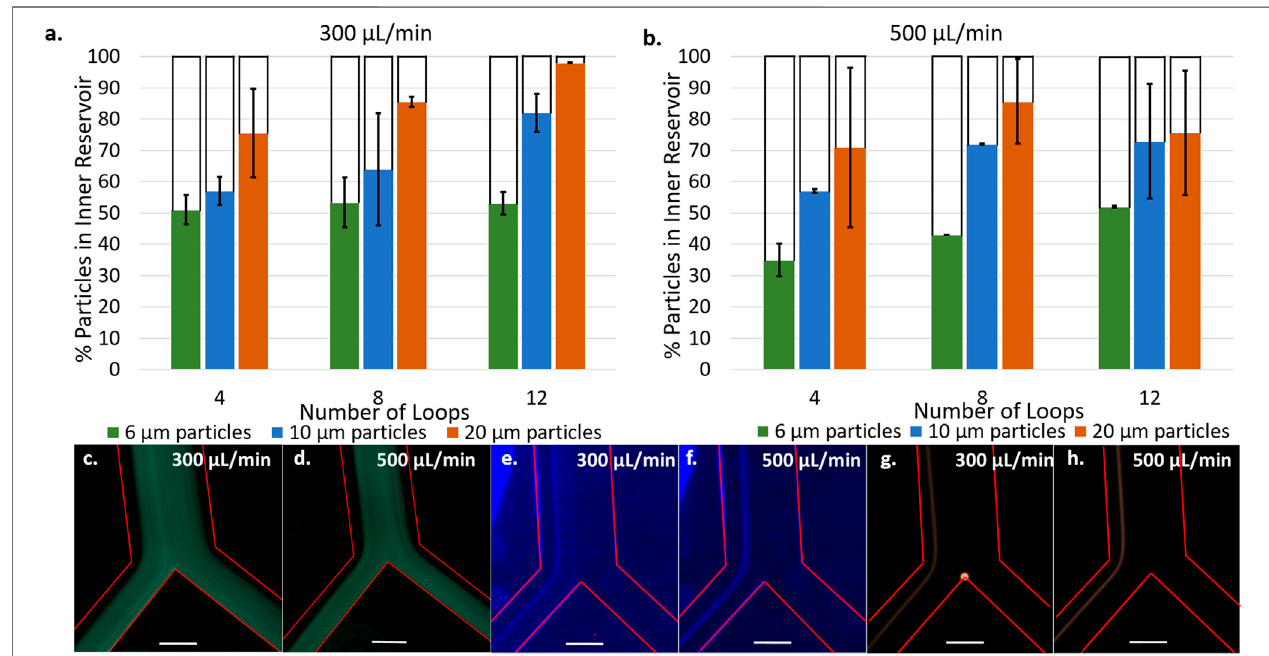
FIGURE4 | Percentage ofparticles counted in inner reservoir in devices with4, 8, and 12loop spirals with 6,10,and 20 µm particles at 300 μ l/min (A) and 500 μ l/ min (B) . [6 µm particles] (cid:2) 5.5 × 10 2 particles/mL, [10 µm particles] (cid:2) 1.18 × 10 4 particles/mL, [20 µm particles] (cid:2) 1.48 × 10 4 particles/mL. Fluorescence microscopy imagesatbifurcationof6 µmparticles fl owingin12loopspiralsat300 μ l/min (C) and500 μ l/min (D) .Fluorescencemicroscopyimagesatbifurcationof10 µm fl owingin 12loopspiralsat300 μ l/min (E) and500 μ l/min (F) .Fluorescencemicroscopyimagesatbifurcationof20 µm fl owingin12loopspiralsat300 μ l/min (G) and500 μ l/ min (H) . Red lines delineate microchannel walls, scale bar represents 250 μ m [6 µm particles] (cid:2) 2.18 × 10 5 particles/mL, [10 µm particles] (cid:2) 4.73 × 10 4 particles/mL, [20 µm particles] (cid:2) 1.48 × 10 4 particles/mL.